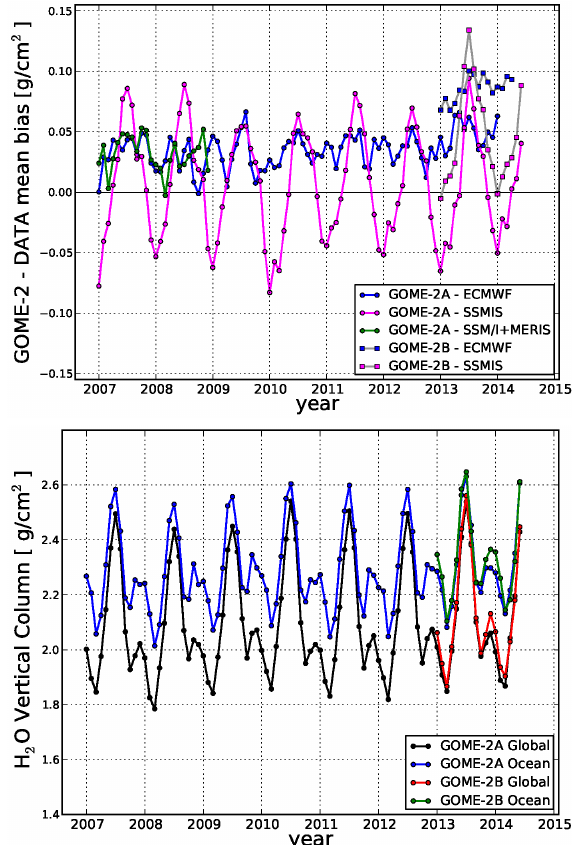
Figure 8. Top panel: global monthly mean bias between GOME- 2/MetOp-A and three independent TCWV data sets for the period January 2007–June 2014, depending on availability of the data. The comparison is performed against ECMWF ERA-Interim re- analysis (blue points), SSMIS F16 satellite (magenta points, only over ocean) and the combined SSM/I + MERIS data set (green points). Coloured squares and grey lines show the bias between the most recent GOME-2/MetOp-B observations and the ECMWF ERA-Interim and SSMIS data sets. Bottom panel: global monthly mean TCWV values for the GOME-2/MetOp-A and the GOME- 2/MetOp-B data sets. The time series are computed for all surfaces (global: land and ocean together) and only for ocean